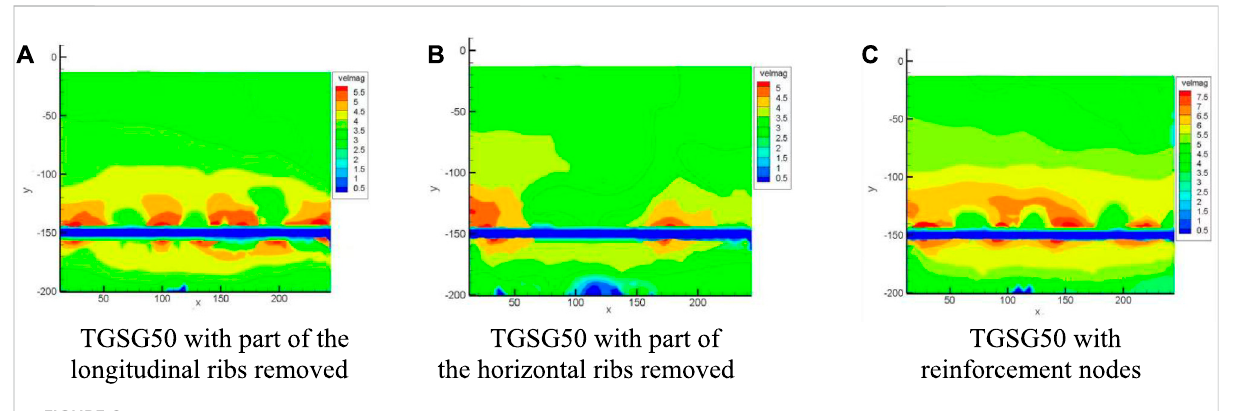
FIGURE 8 The displacement cloud map under different types of grids (at the pullout peak). (A) TGSG50 with part of the longitudinal ribs removed. (B) TGSG50 with part of the horizontal ribs removed. (C) TGSG50 with reinforcement